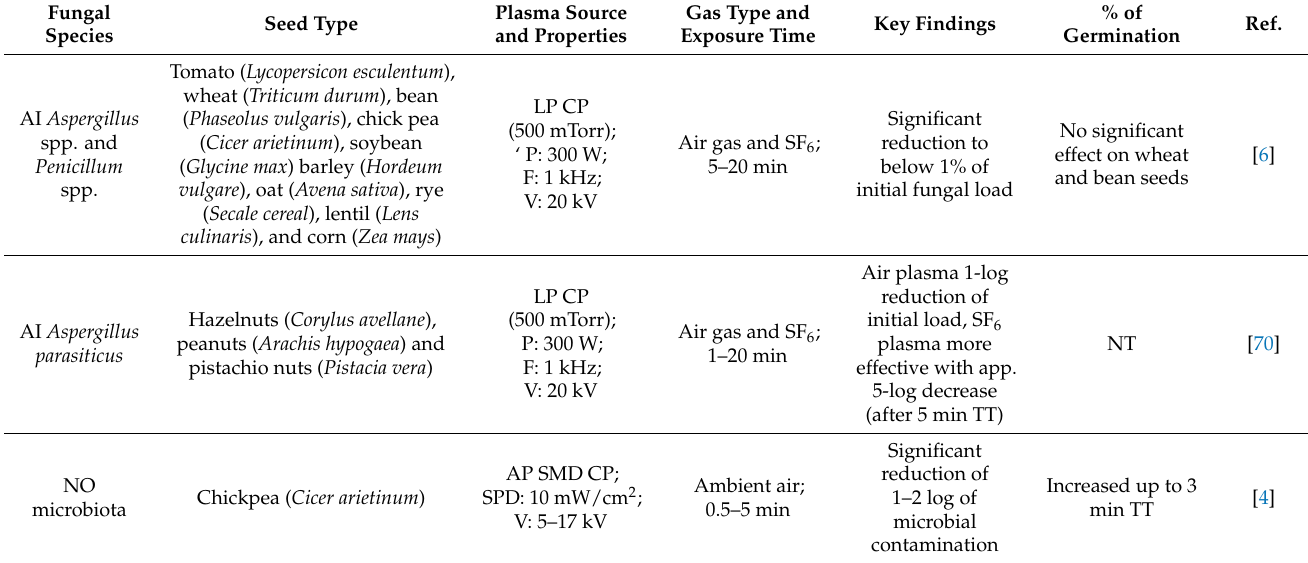
Table 1. An overview of experiments studying the effects of cold plasma on fungal decontamination in various plant species. AI: Artificially infected. NO: naturally occurring. CP: cold plasma. LP: low-pressure. AP: atmospheric-pressure. SMD: Surface micro-discharge. FB: fluidized bed. DCSBD: Diffuse Coplanar Surface Barrier Discharge. RF CC: radio-frequency capacitively coupled. (S)DBD: (Surface) Dielectric Barrier Discharge. CDPJ: Corona Discharge Plasma Jet. P: power. F: frequency. V: voltage. SPD: surface power density. PVD: power volume density. TT: treatment time. NT: not